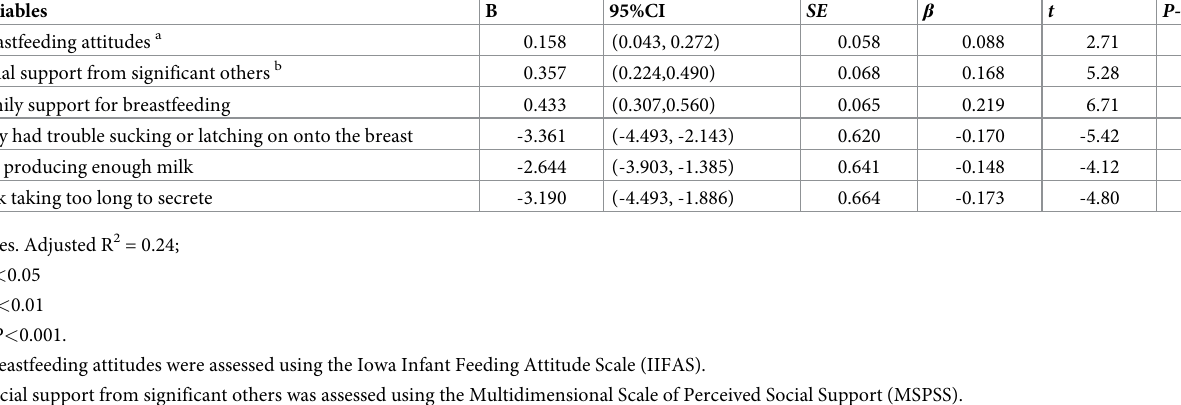
( r = 0.166, P < 0.001), family support for breastfeeding ( r = 0.297, P < 0.001) and social support ( r = 0.214, P < 0.001) have significantly positive correlations with BSE. At the same time, the results show that depression (EPDS score: r = -0.099, P = 0.006; DASS of Depression: r = -0.120, P < 0.001) and stress ( r = -0.137, P < 0.001) had significantly negative relationships with BSE.